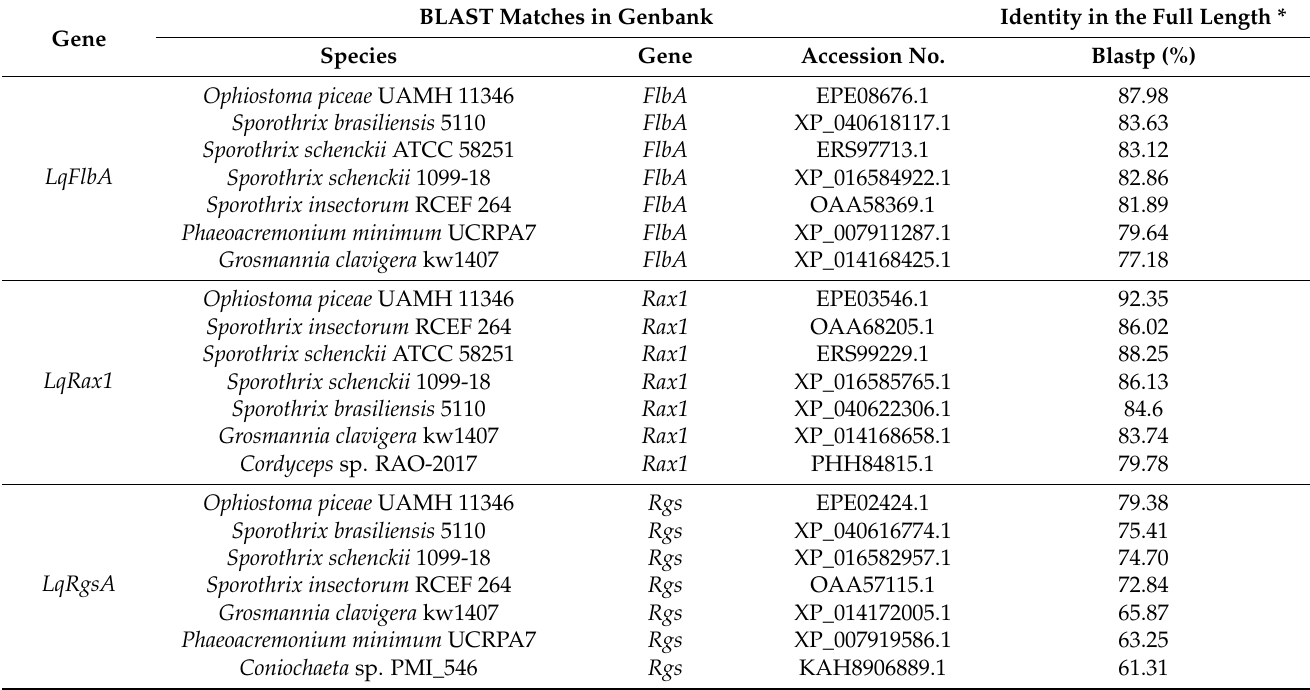
Table 3. Amino acid identity of regulators of G-protein signaling genes isolated from L. qinlingensis with related sequences in other fungi species.